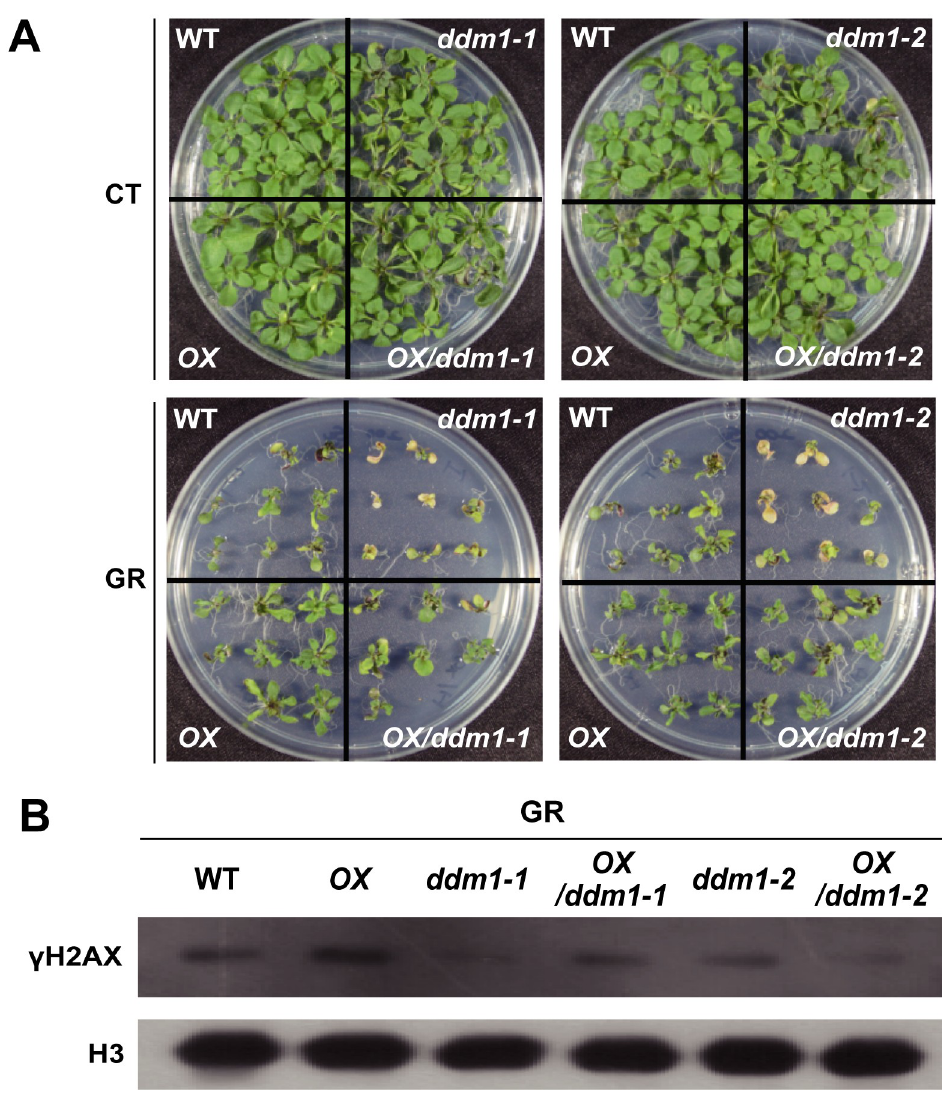
Fig 7. Complementation of DDM1 mutation by overexpressing the full-length cDNA of DDM1 in the ddm1 mutant is effective. (A) Phenotypes of transgenic lines overexpressing the DDM1 cDNA in WT and ddm1 mutant backgrounds in response to gamma irradiation. Seedlings were grown for 18 days after gamma irradiation at 200 Gy for 4 h. CT, control; GR, gamma radiation. (B) Immunoblot of γ -H2AX in transgenic lines overexpressing the DDM1 cDNA in WT and ddm1 mutant backgrounds after gamma irradiation at 200